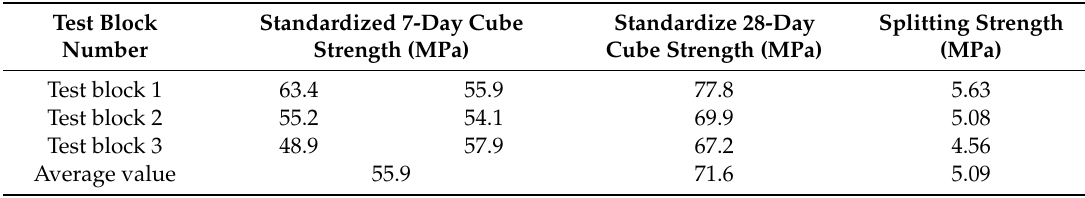
Table A5. Concrete strength obtained from the experimental test on standard C60 HPC cubic